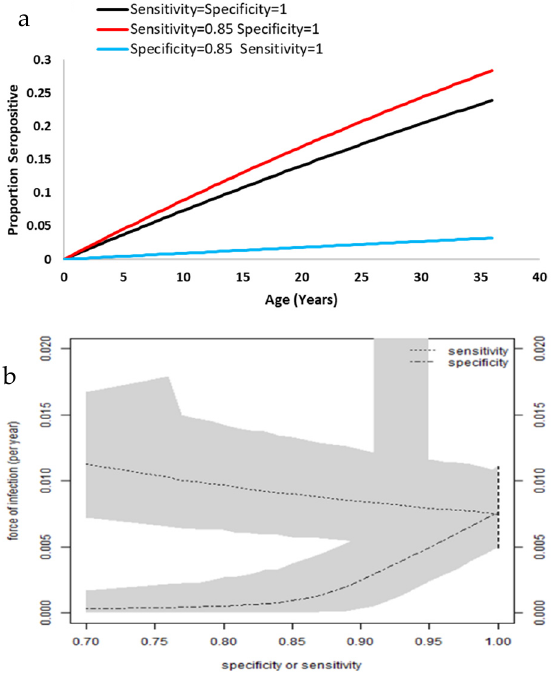
Figure 2. Representation of seropositivity by age and the force of infection. ( a ) Proportion of seropositive patients by age. ( b ) Relation between force of infection, sensitivity, and specificity. The grey zones represent the 95% credible intervals. As the credible intervals approach the 95% confidence interval (vertical dashed line), the sensitivity and specificity approach 100%.